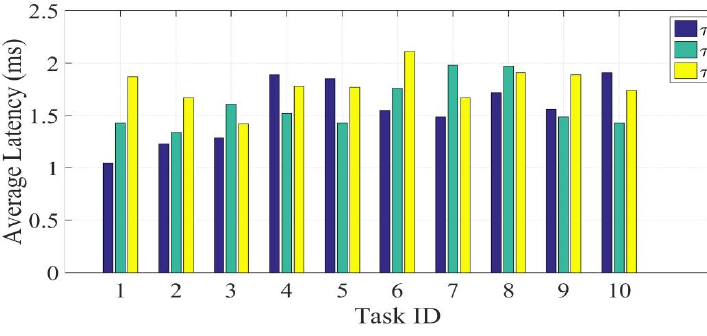
Future Internet 2019 , 11 , x FOR PEER REVIEW Figure 10. The average latency of handling the first group of tasks. Figure 10. The average latency of handling the first group of tasks.